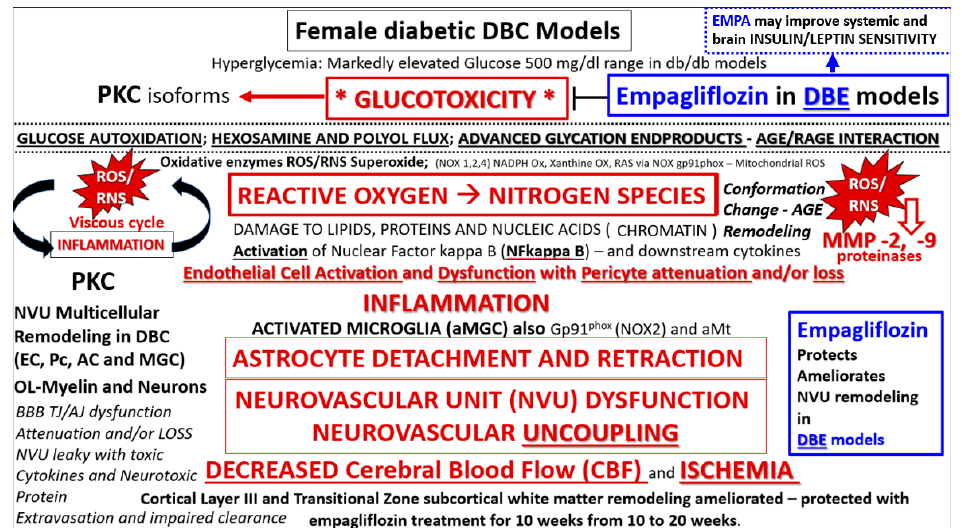
Figure 14. Possible mechanisms for remodeling changes in diabetic db / db mice and protection by EMPA. We propose an overarching hypothesis that hyperglycemia and glucotoxicity serve as a central injury mechanism to cells and tissues and are definitely upstream of diabetic end-organ complications, which may include microvascular disease and ultrastructure remodeling of the neurovascular unit in the brains of type 2 diabetes mellitus (T2DM) db / db mice and human patients. We have previously identified the observational abnormal remodeling associated with the NVU and its supportive cellular constituents (endothelial cell, pericyte, astrocyte, microglia and regional neurons) [1–3]. It is important to note that 10-week administration of EMPA protected the NVU and it supportive cells and neurons from US remodeling. In support of this, a recent paper showed that EMPA administration was associated with decreased cerebral-oxidative stress, increase brain-derived neurotrophic factor, and significantly prevented the impairment of cognitive function [8]. Importantly, note that empagliflozin in DBE models improves glucotoxicity and may also improve insulin and leptin sensitivity. AC = astrocyte; EC = endothelial cell; AGE = advance glycation end product; aMt = aberrant mitochondria; MGC = microglia cell; MMP = matrix metalloproteinase; NADPH Ox = nicotinamide adenine dinucleotide phosphate oxidase; NOX 1,2,4 family genes encoding NADPH Ox 1,3,4 Ox = oxidase; PKC = protein kinase C; RAGE = receptor for AGE; RAS = renin angiotensin aldosterone system; RNS = reactive nitrogen species; ROS = reactive oxygen species; TJ/AJ = tight junction/adherens